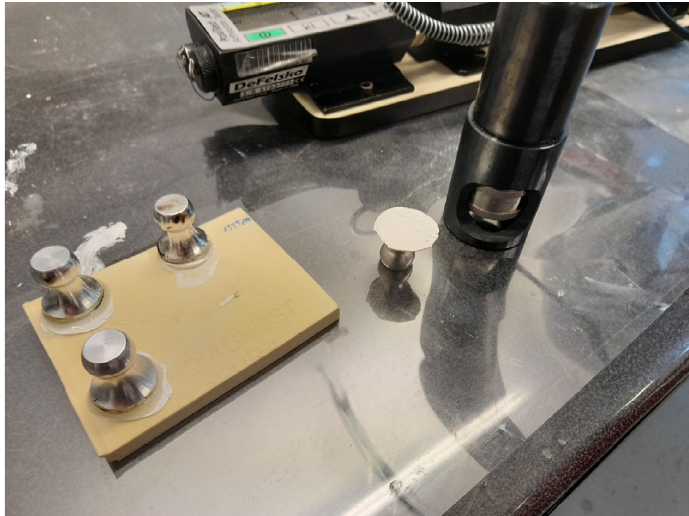
Figure 6. Pull ‐ off adhesion test of coated PUR samples. Figure 6. Pull-off adhesion test of coated PUR